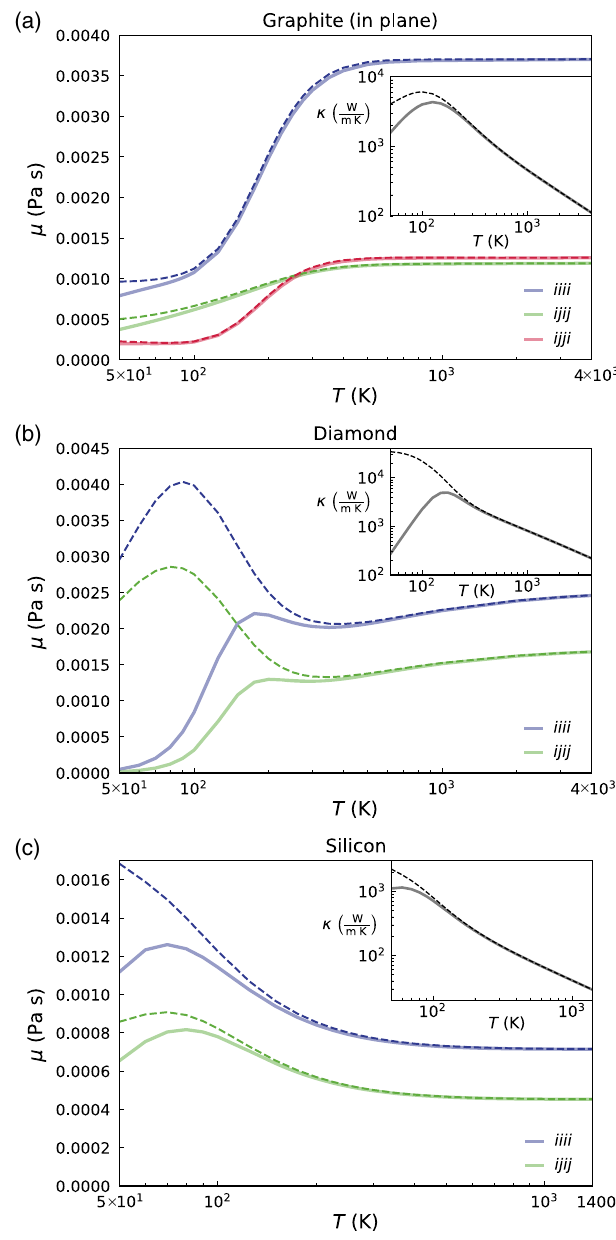
FIG. 1. Largestcomponents of the fourth-order thermal viscosity tensor for graphite (a), diamond (b), and silicon (c), as a function of temperature (the off-plane tensor components for graphite are reported in Fig. 9). Insets: Total thermal conductivities (in-plane components for graphite and diagonal components of the isotropic tensor for diamond and silicon) as a function of temperature. The dashed lines refer to the bulk materials [Eq. (9) for viscosity and Eq. (B12) for conductivity], the solid lines show finite-size predictions computed using Eqs. (C1) and (C2) for a sample having size (or grain size) 10 μ m (see main text and Appendix C; for diamond and silicon the component μ ijji is